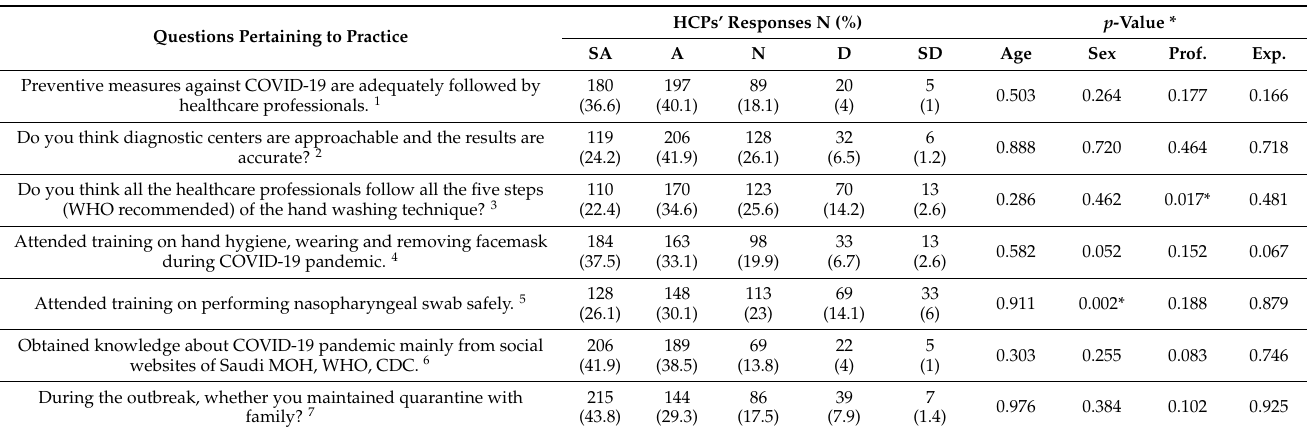
Table 5. Practice towards